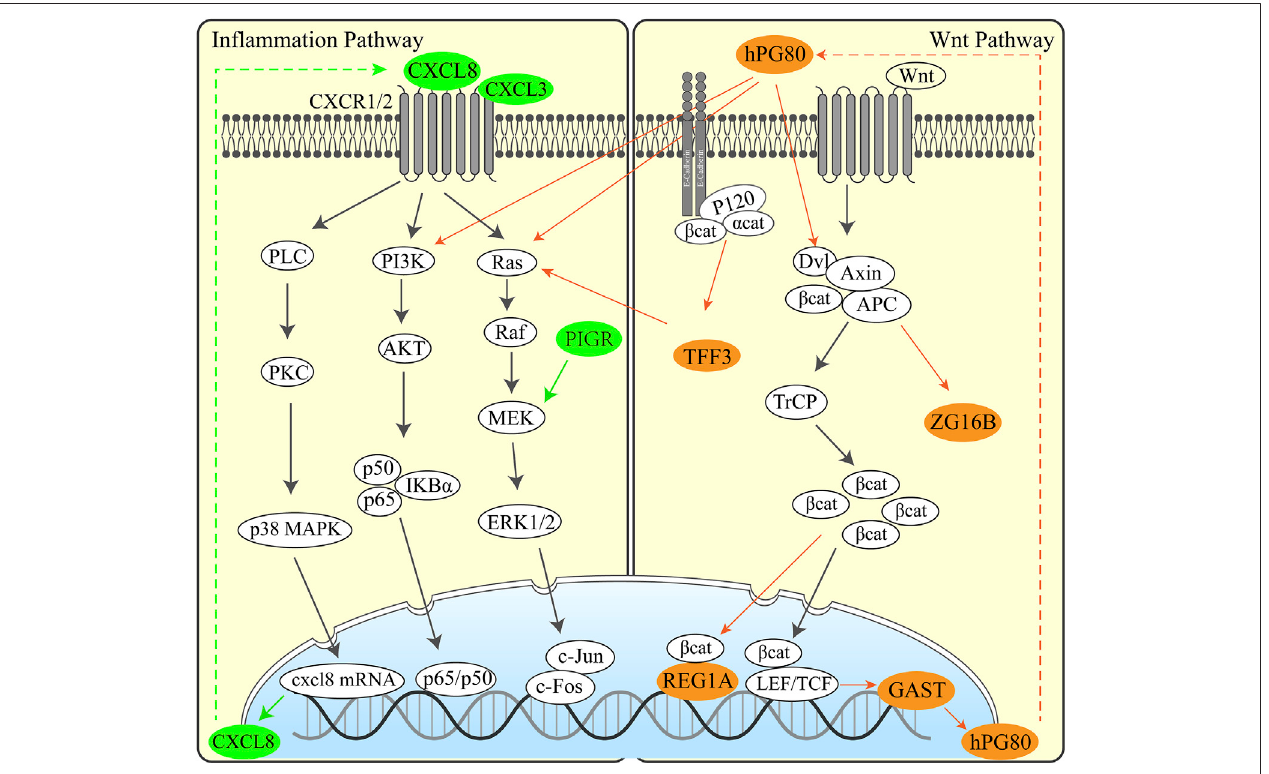
FIGURE 6 | Regulation pathway in UGCSCs. In fl ammatory pathway (left) and Wnt pathway (right) activated in UGCSC. The green genes represent in fl ammatory factors that are highly expressed in UGCSCs. The brown – yellow genes represent Wnt-related factors that are highly expressed in UGCSCs.